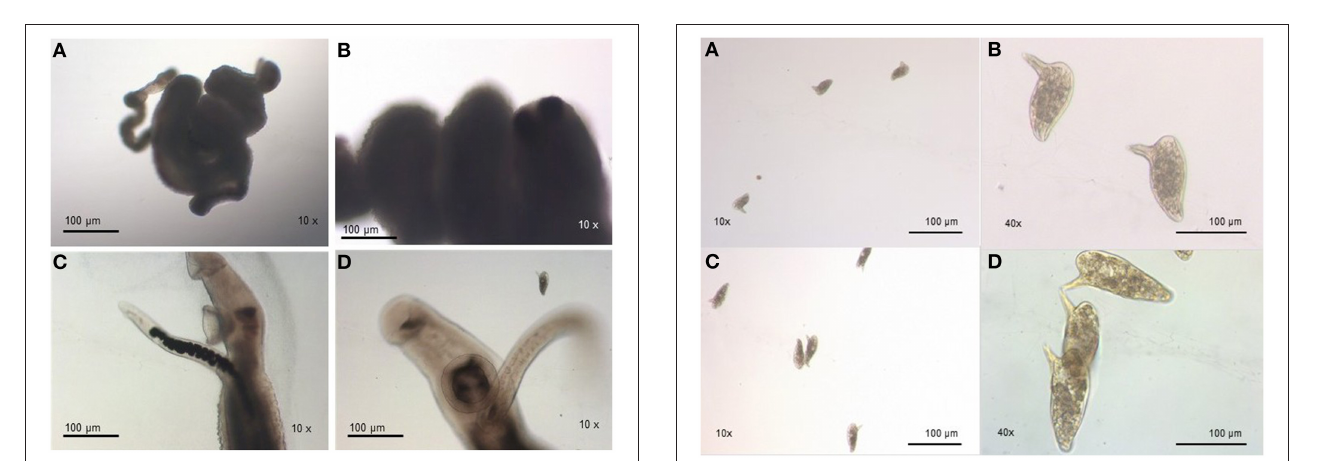
FIGURE 4 | Morphological difference between eggs from resistant strain and susceptible strain. (A) Eggs from resistant strain parasites, showing morphology alterations, smaller size, and smaller lateral spines (10x); (B) Eggs from resistant strain, in a bigger scale, showing morphology alterations, smaller size, and smaller lateral spines (40x); (C) Eggs from susceptible strain parasites, showing normal morphology (10x); (D) Eggs from susceptible strain parasites, showing normal morphology, in a bigger scale (40x).